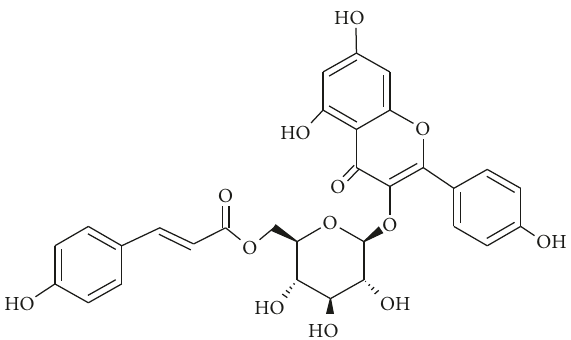
Figure 1: Structure of tiliroside (using the ACD/Chemsketch program, version 12.5 (Advanced Chemistry Development,